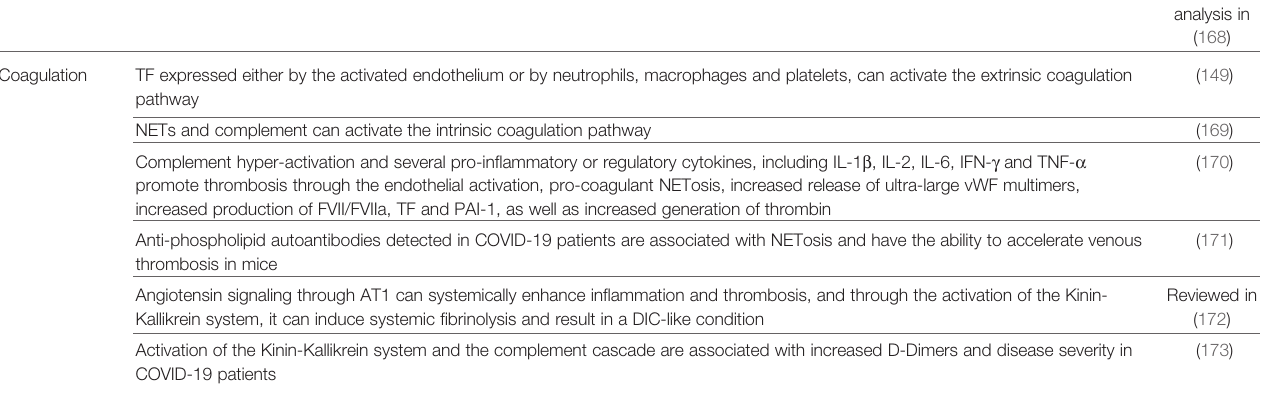
TABLE 2 | Proposed mechanisms contributing to the (immuno)thrombosis observed in COVID-19 patients. Effector cells/ molecules